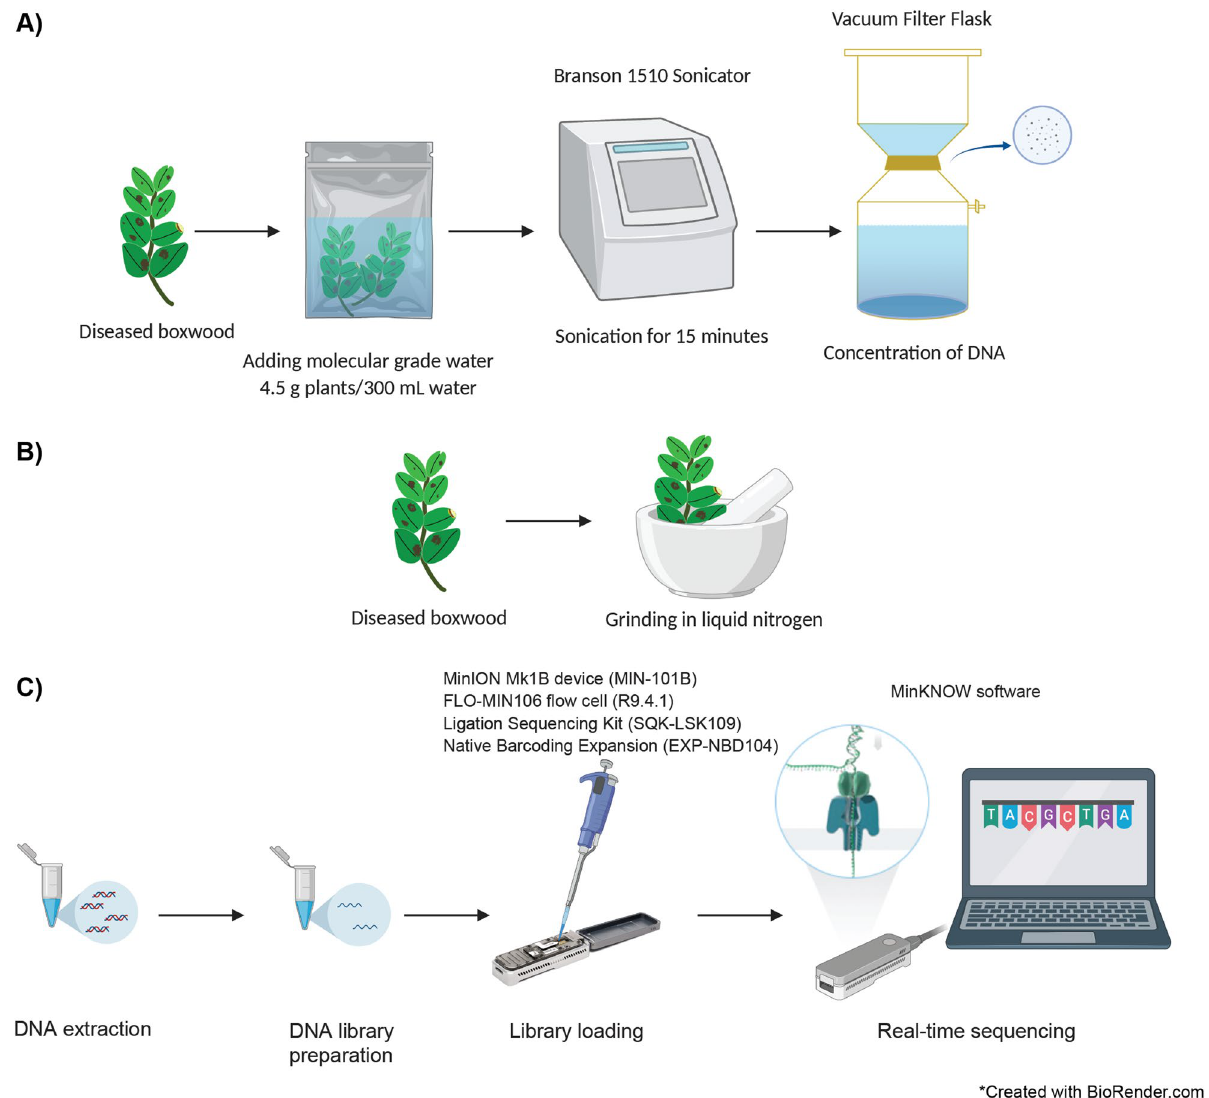
Figure 1. Pipelines for detection and identification of Calonectria pseudonaviculata ( Cps ). ( A ) DNA extraction approach based on sonication without disrupting plant cells. ( B ) DNA extraction approach based on homogenization in liquid nitrogen with disrupting plant cells. ( C ) The MinION sequencing pipeline. Created with MinION library preparation and sequencing. MinION Library preparation was performed accord- ing to the native barcoding genomic DNA protocol (EXP-NBD104, EXPNBD114, and SQK-LSK109) 26 with minor modifications. The library was prepared using the Ligation Sequencing Kit (ONT; SQK-LSK109). For each run, first, DNA for each sample was repaired and end-prepped for each sample using the NEBNext Ultra II End Repair/dA-Tailing Module (New England Biolabs, Inc.; Catalog # E7546S). 90 μL AMPure XP beads were used for cleaning up repaired DNA. Then repaired DNA was washed on a magnetic rack using freshly made 70% ethanol and eluted with 25 μL nuclease-free water. Second, native barcode ligation was performed by mix- ing 22.5 μL of the elute with the Blunt/TA Ligase Master Mix (New England Biolabs, Inc.; Catalog # M0367S) and Native Barcode (ONT; Native Barcoding Expansion Kit EXP-NBD104). Barcoded DNA was cleaned up by another wash step using 90 μL AMPure XP beads, and DNA was eluted in 26 μL nuclease-free water. Then equimolar amounts of each barcoded DNA were pooled into a 1.5 mL microcentrifuge tube. Last, adapter liga- tion was performed by mixing the pooled barcoded sample with Adapter Mix (ONT; SQK-LSK109), NEBNext Quick Ligation Reaction Buffer (New England Biolabs, Inc.; Catalog # B6058S) and Quick T4 DNA Ligase (New England Biolabs, Inc.; Catalog # M2200S). Ligated DNA was cleaned up with 60 μL AMPure XP beads, washed on a magnetic rack using Long Fragment Buffer (ONT; SQK-LSK109), and eluted with 15 μL Elution Buffer (ONT; SQK-LSK109). Sequencing reactions were performed independently for each run on a MinION flow cell (ONT; FLO-MIN106 R9.4.1 Version) connected to a Mk1B device (ONT; MIN-101B) operated by the MinKNOW software (ONT, Inc. v19.12.2). Each flow cell was primed with the priming buffer prepared by mixing 30 μL Flush Tether (ONT;